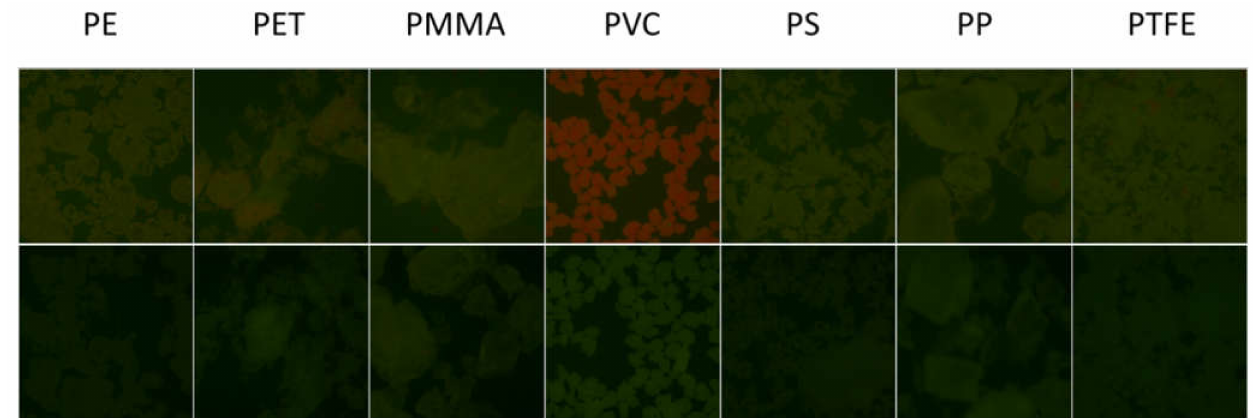
Figure 7. ( Top ) From left to right: RGB color images of PE, PET, PMMA, PVC, PS, PP and PTFE particles after 2 h incubation with P in buffered water solution (pH = 7) at concentration 8 µ M obtained with a fluorescence inverted microscope upon illumination with a blue LED diode in epifluorescence mode. Images were acquired with a conventional CMOS camera directly in the P solutions, without any washing. The lateral size of each image is 1.8 mm. ( Bottom ) Images of the fluorescence of the same polymers in the same conditions without staining.